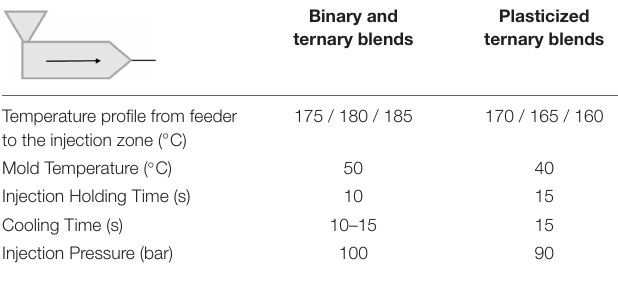
TABLE 2 | Injection molding